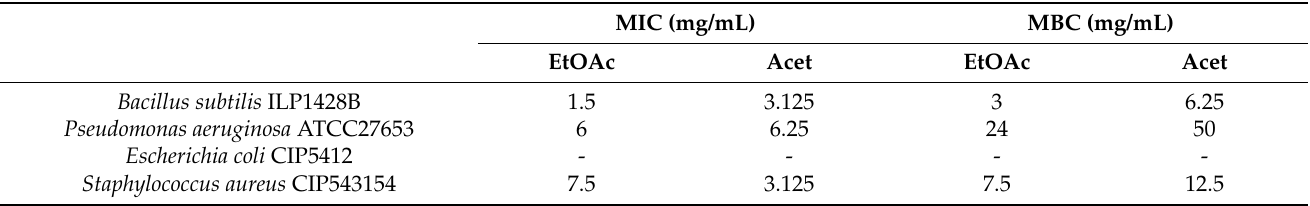
Table 1. Antibacterial activities of CSP extracts (EtOAc: Ethyl acetate extract, Acet: Acetone extract) expressed as MIC and MBC in